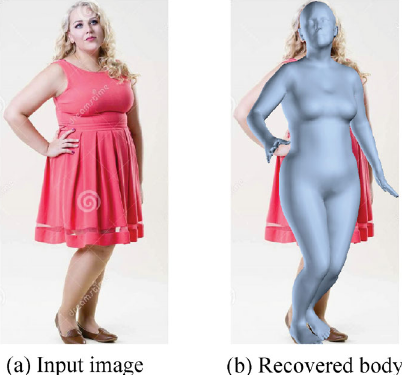
Fig. 2 Prediction results using the state of the art [18]. The model captures the shape of the human body by learning from synthetic data. The recovered legs and chest are close to those of the person in the image. Reproduced with permission from Ref. [18], c (cid:2) The Author(s)